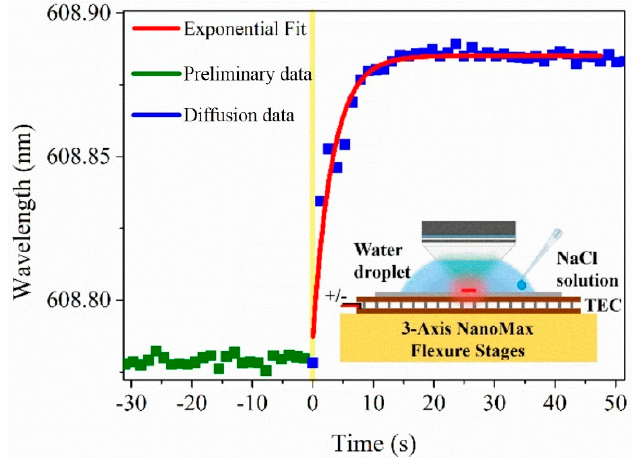
Figure 8. Monitoring the process of mixing NaCl solution with water using the lasing chemical sensor. The yellow line represents the diffusion process. Inset shows the schematic diagram of operation process.